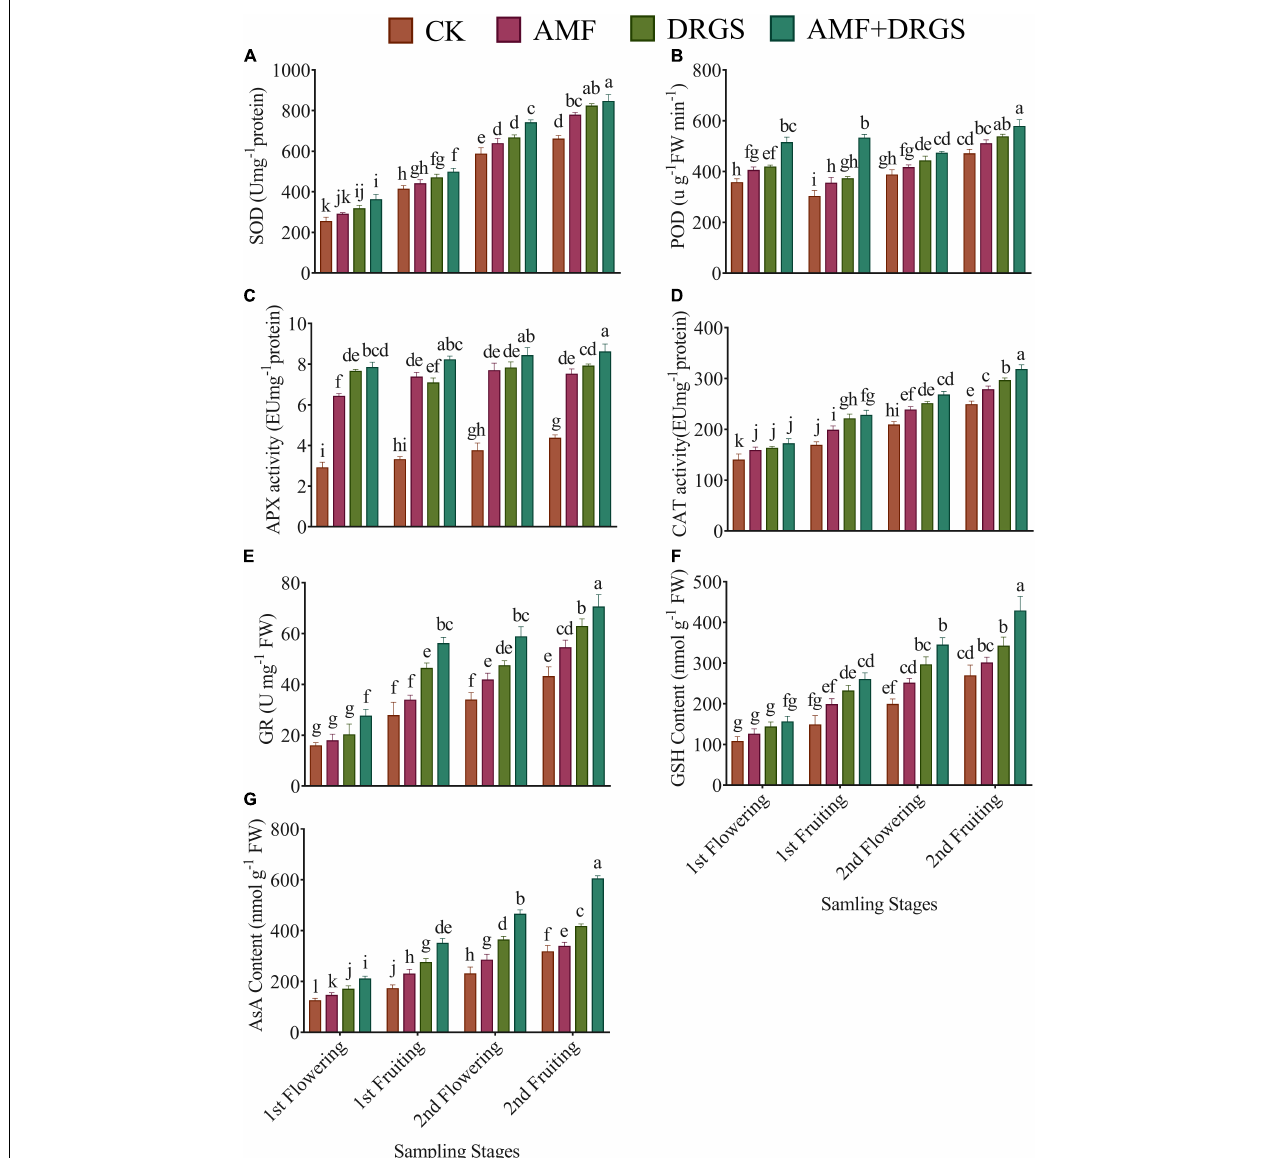
FIGURE 7 | Effect of AMF inoculation and amendment with dry raw garlic stalk on superoxide dismutase (SOD) (A) , peroxidase (POD) (B) , ascorbate peroxidase (APX) (C) , catalase (CAT) (D) , glutathione reductase (GR) (E) , reduced glutathione (GSH) (F) , ascorbic acid (AsA) (G) on eggplant leaves at 1st flowering, 1st fruiting, 2nd flowering, and 2nd fruiting stages. Data represent the mean of ± SE ( n = 5). Different letters show significant differences within treatments. Tukey’s HSD test was employed to verify statistical significance at p <